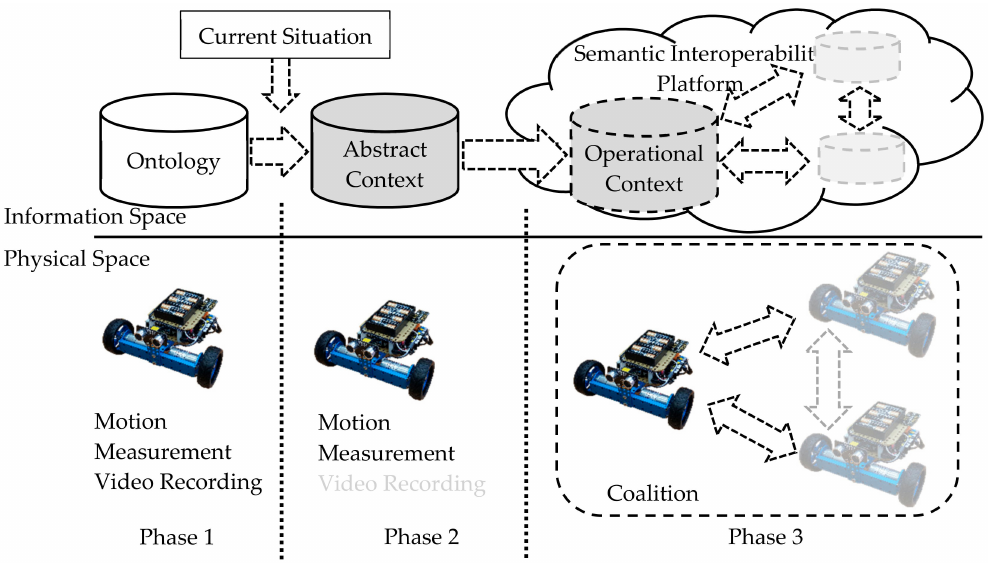
Figure 1. Abstract and operational contexts for coalition